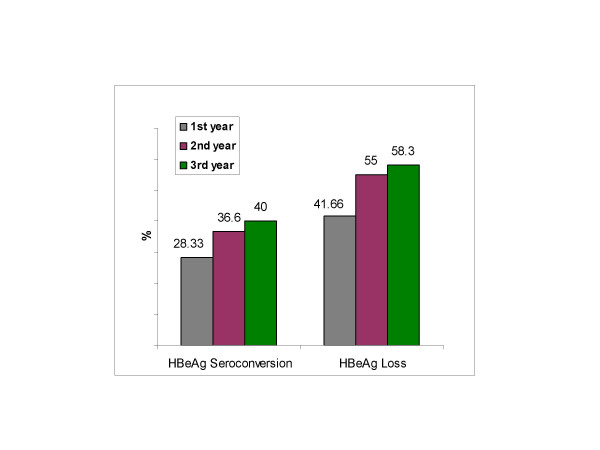
Cumulative HBeAg seroconversion and loss in 60 patients.